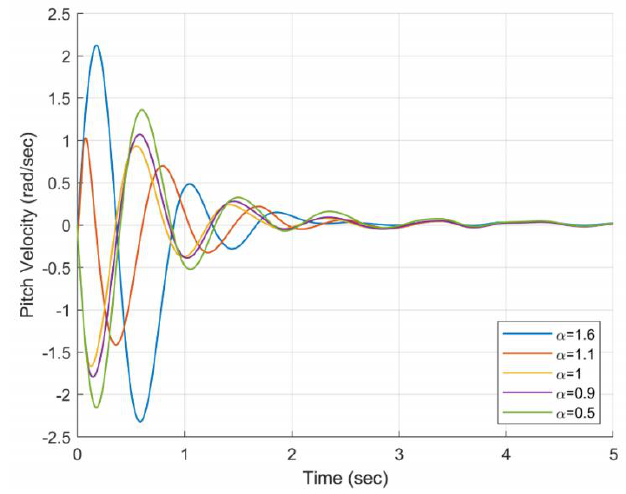
Figure 6. Variation of pitch velocity at different orders.